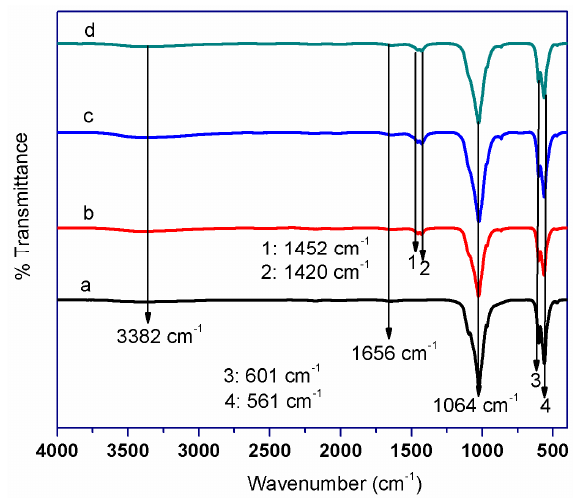
Figure 2. FT-IR spectra of ( a ) Sm-FAp/Glutamic acid; ( b ) Sm-FAp/Aspartic acid; ( c ) Sm-FAp/Glycine ( d ) ( d ) Sm-FAp/Histidine.